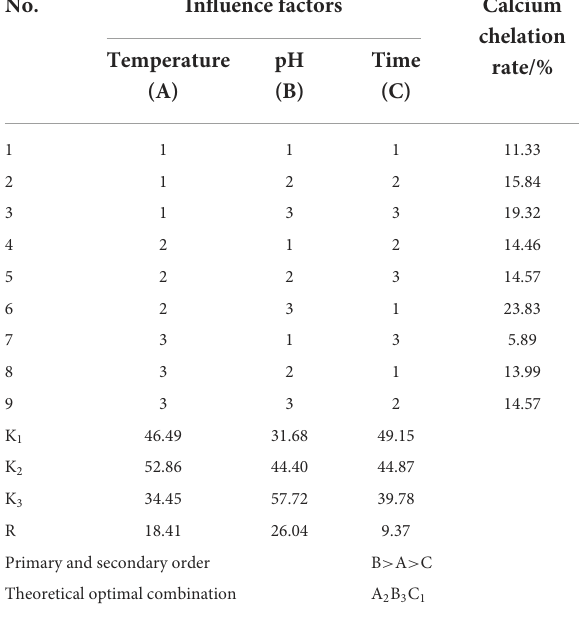
TABLE 2 The analysis of orthogonal experiment